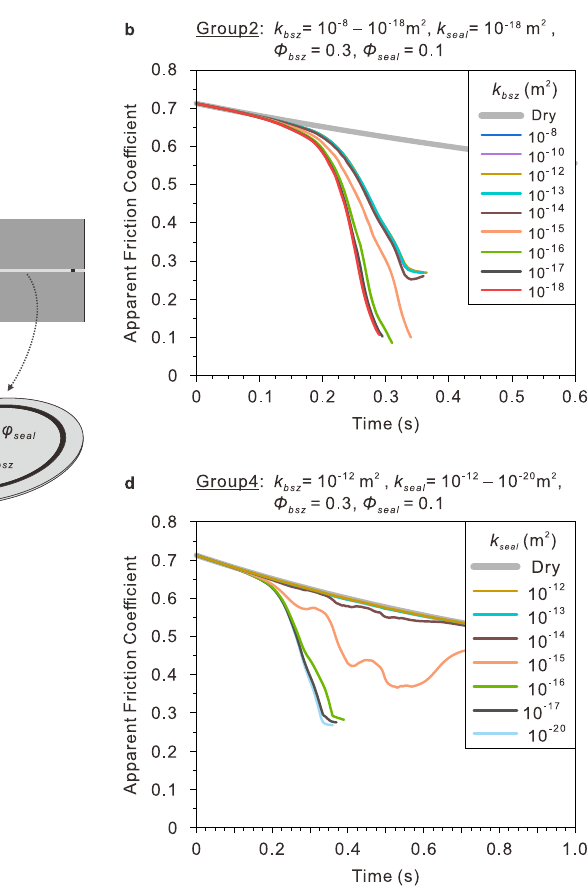
andporosity( Φ )ofbulkshearzone( k bsz and Φ bsz )andsealingzone( k seal and Φ seal ) (see details of the model setting in Supplementary Fig. S6; some curves overlap in the fi